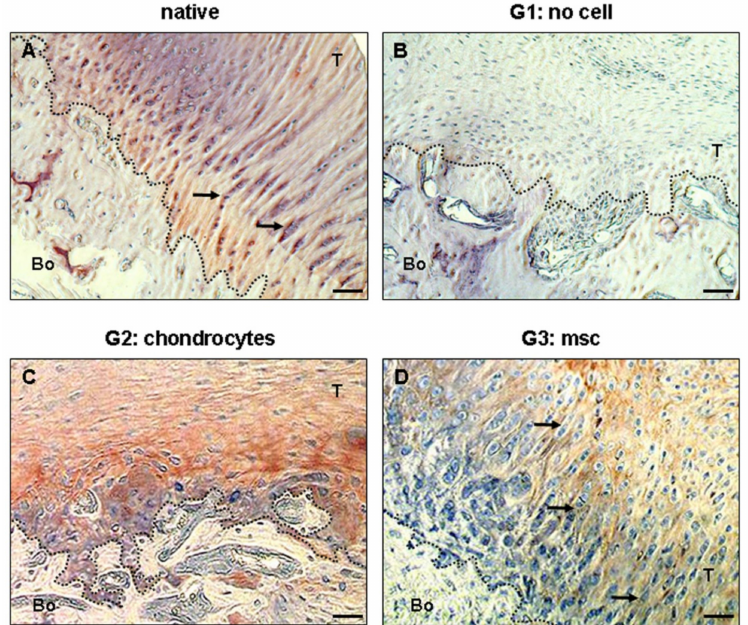
Figure 2. Restoration of enthesis organisation by MSC injection 45 days post-repair. Reprinted and adapted with permission from Ref. [34]. Copyright 2010 PLOS ONE. ( A ) Immunohistochemical staining for collagen II was performed on native entheses. ( B ) 45 days post-repair enthesis from control G1. ( C ) chondrocyte-injected G2. ( D ) MSC-injected G3 rats. (Figure 2A) Native enthesis contained chondrocyte columns (arrows) at the bone- tendon junction, and positive collagen II immunostaining was observed at the junction.